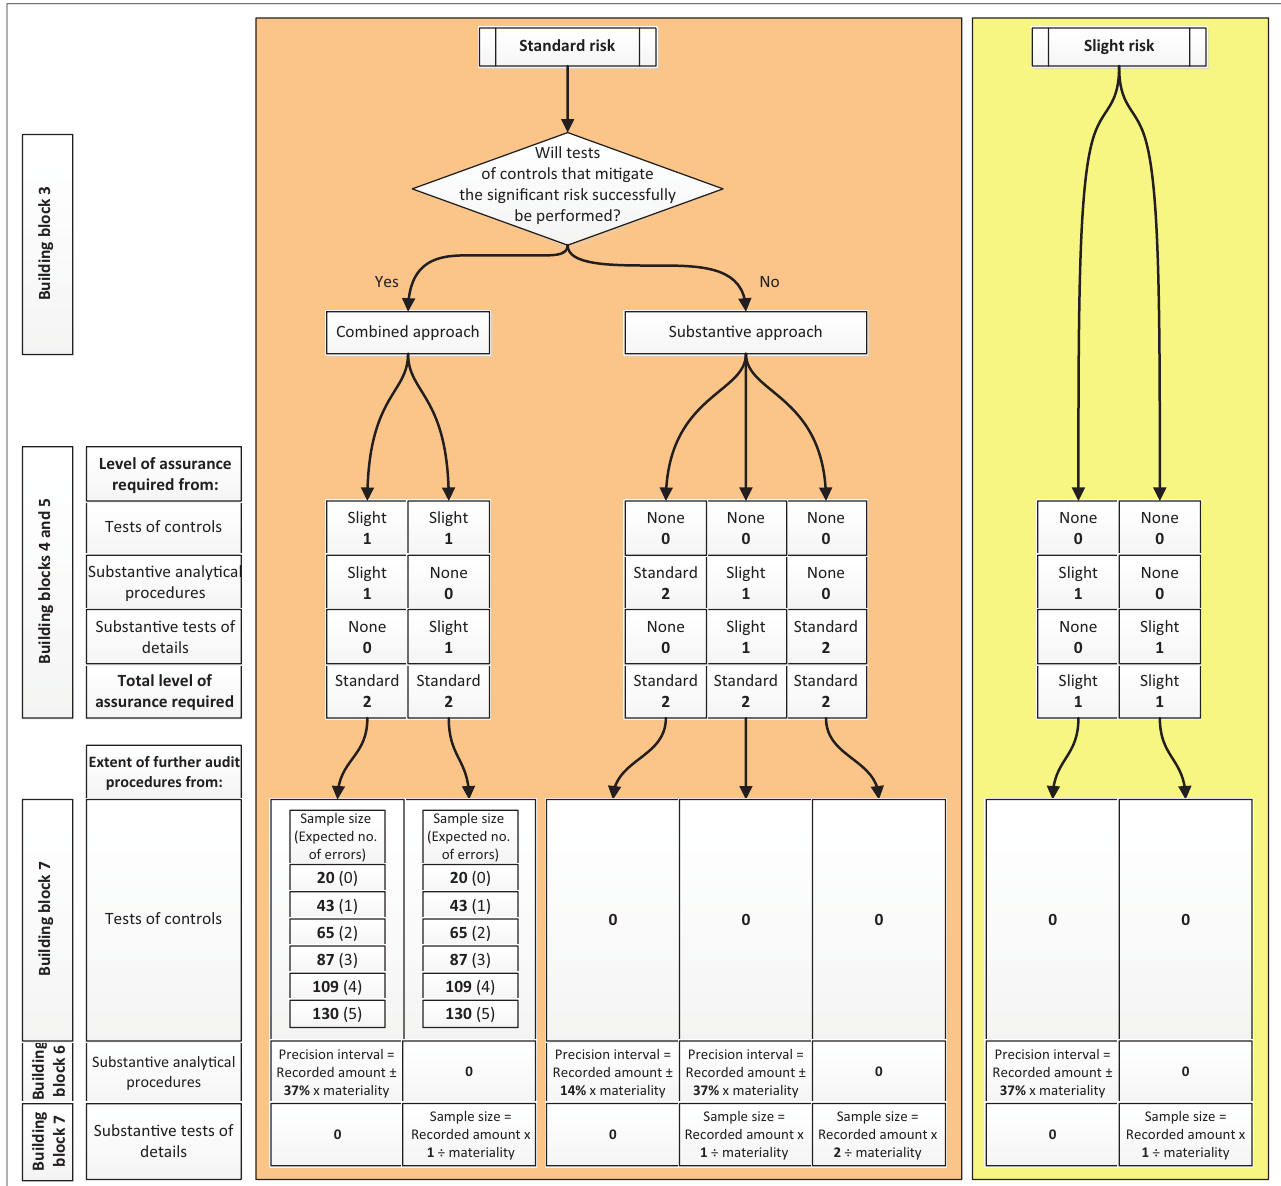
FIGURE 3: The integrated evidence planning model for standard and slight risk assertions, classes of transactions, account balances and